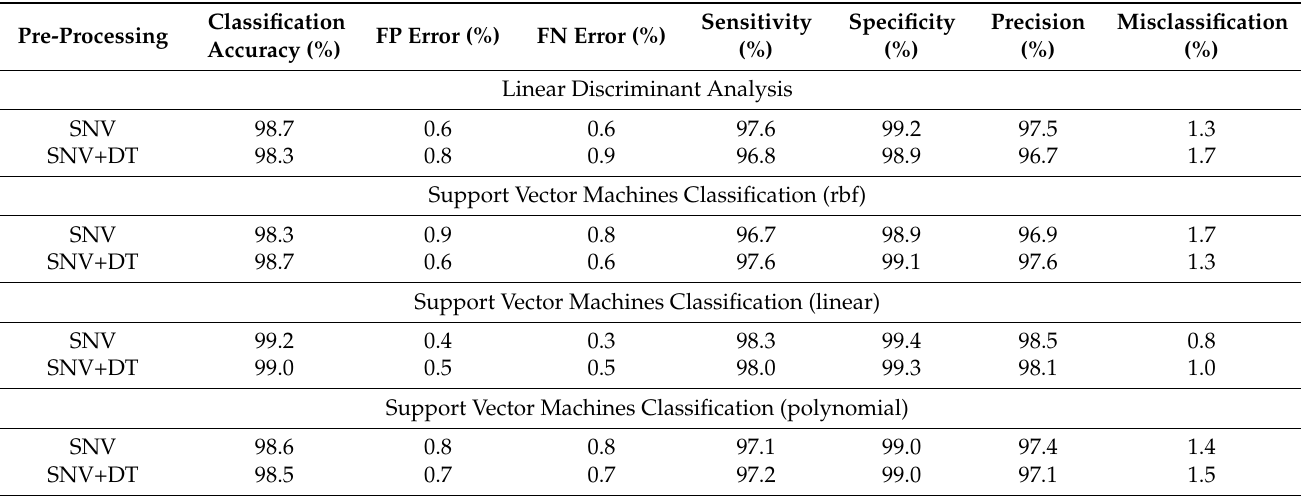
Table 6. The overall performance measures used to assess the validation results for the classification of patties into four classes.